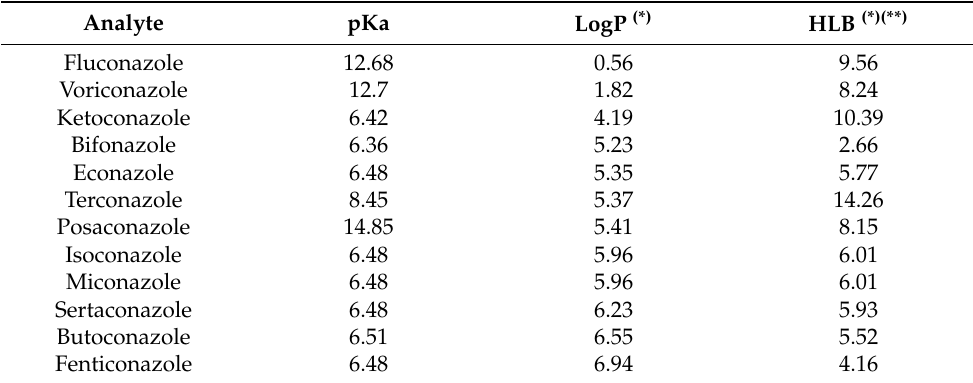
Table 1. pKa, logP, and HLB values of the studied antifungal